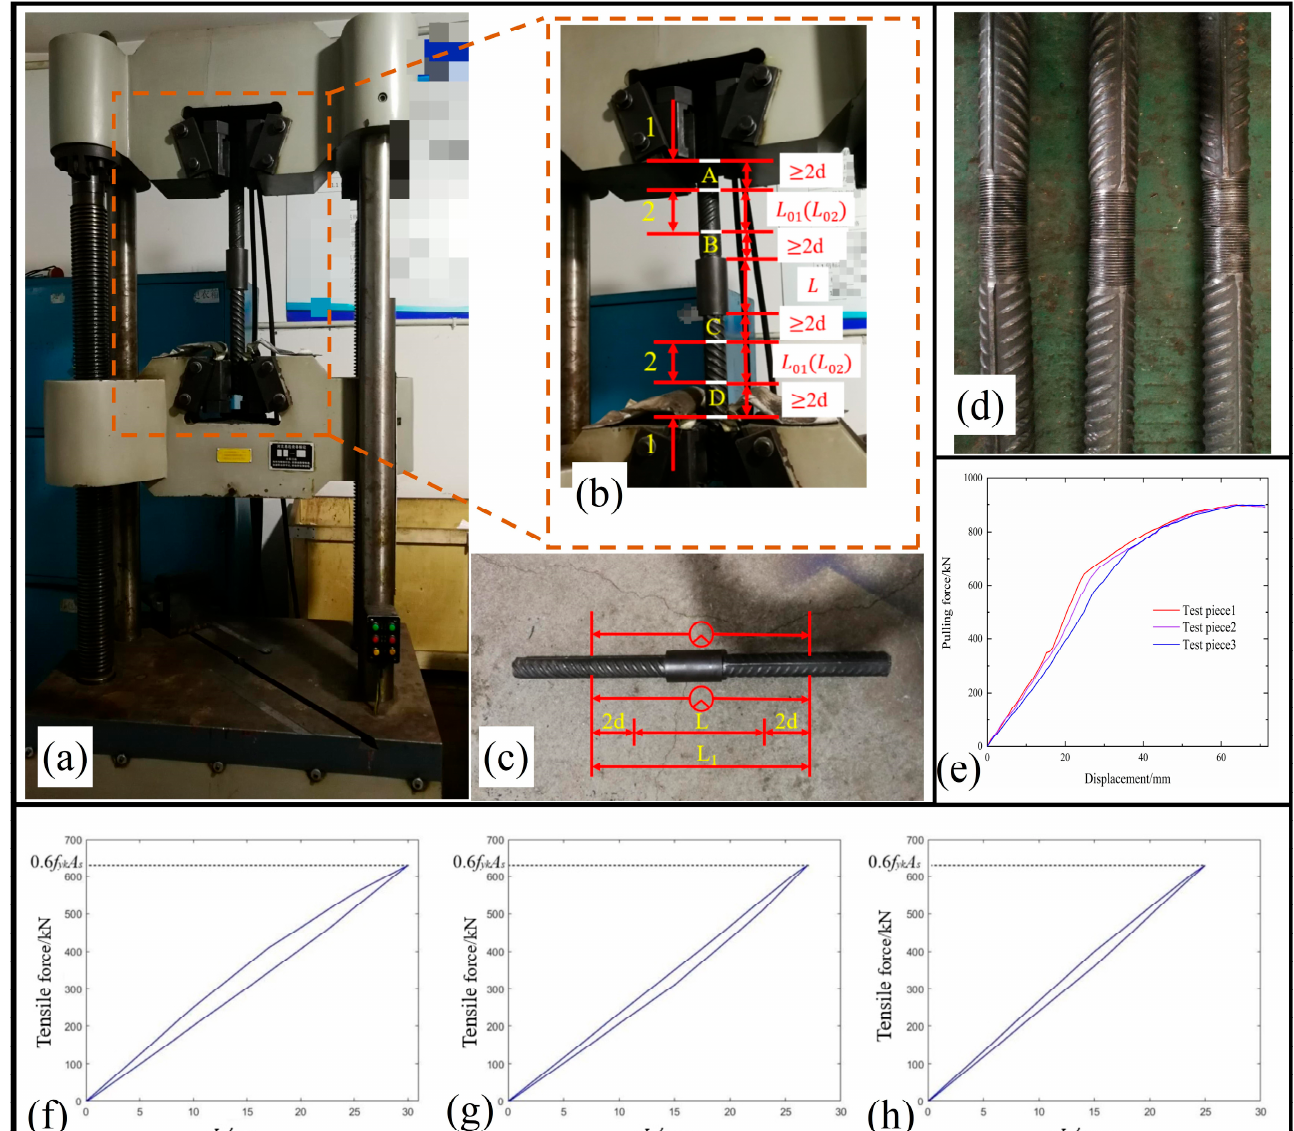
Figure 4. Mechanical property test. ( a ) Tensile machine. ( b ) Distribution of measuring points for total elongation (1—Clamping area; 2—Test area). ( c ) Gauge distance and instrument arrangement for deformation measurement of connecter. ( d ) Three groups of specimens after processing. ( e ) The curve of pulling force with displacement. ( f – h ) Tensile displacement curves of three groups of specimens after the fi rst unloading.